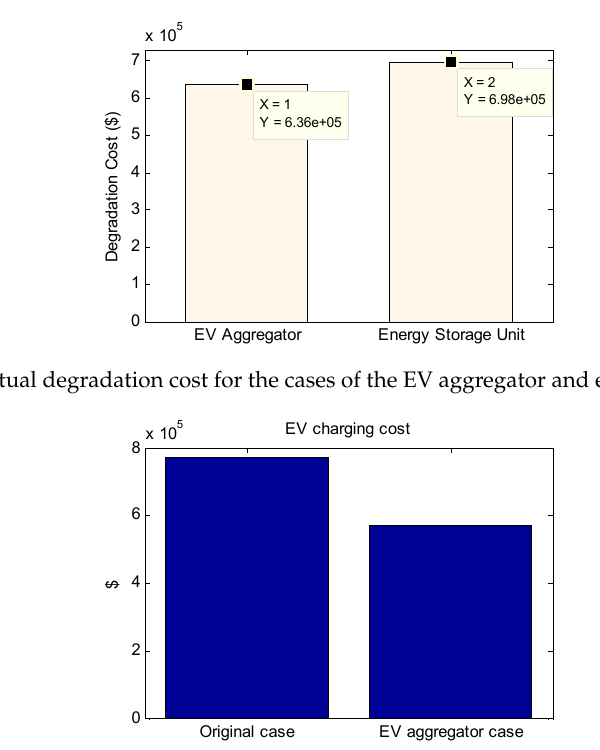
Figure 16. EV charging cost for the cases of EV aggregation vs. the no EV aggregation.